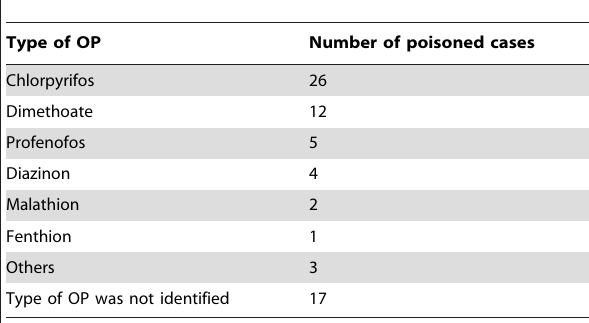
Table 2. Number of poisoned cases by type of OP.